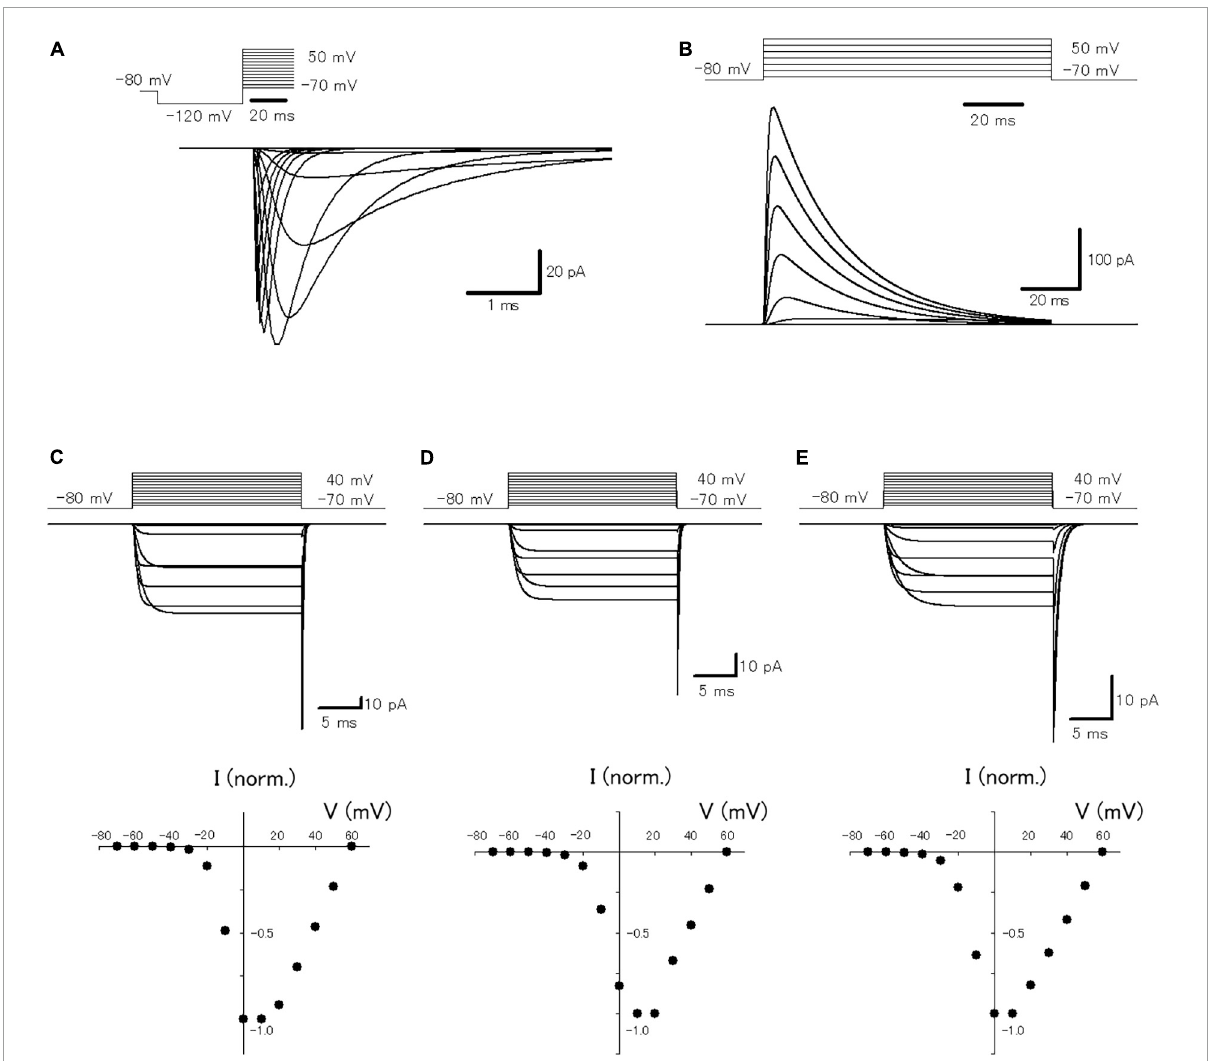
FIGURE1 Reconstruction of axonal sodium and potassium current as well as presynaptic calcium current at the hippocampal mossy fiber boutons. (A) The voltage-dependency of activation of the simulated axonal sodium current. Traces of calculated sodium current at various test potentials: holding potential at − 80 mV for 10 ms, pre-pulse at − 120 mV for 30 ms, and test pulses between − 70 and +70 mV with 10 mV increments. (B) The voltage-dependency of activation of the simulated axonal potassium current. Traces of calculated potassium current by test pulses between − 70 and +50 mV with 20 mV increments. The voltage-dependency of activation of the reconstructed P/Q-type (C) , N-type (D) , and R-type (E) components of presynaptic calcium current. Traces of calculated calcium current at various test potentials: holding potential − 80 mV, test pulses to between − 70 and +40 mV with 10 mV increment, and step back to − 80 mV. The lower graphs represent the I–V relationship of the reconstructed P/ Q-, N-, and R-type components of presynaptic calcium